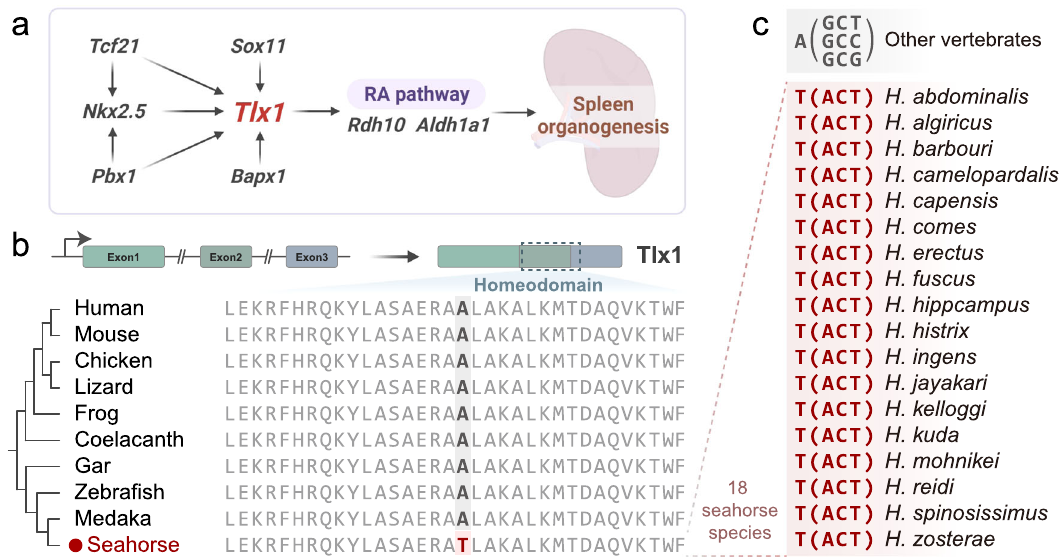
Fig. 2 | Seahorse-speci fi c mutation of the tlx1 gene. a Schematic diagram of the involved genesduringspleen growthand morphogenesis (modi fi edfrom previous studies 18 ).Red color Tlx1,the sequence-speci fi c variation inseahorses; RA, retinoic acid. b Gene structure (upper panel) and multiple amino acid alignments (lower panel) of Tlx1. Seahorse harbors a missense mutation of A (Alanine, Ala) to T